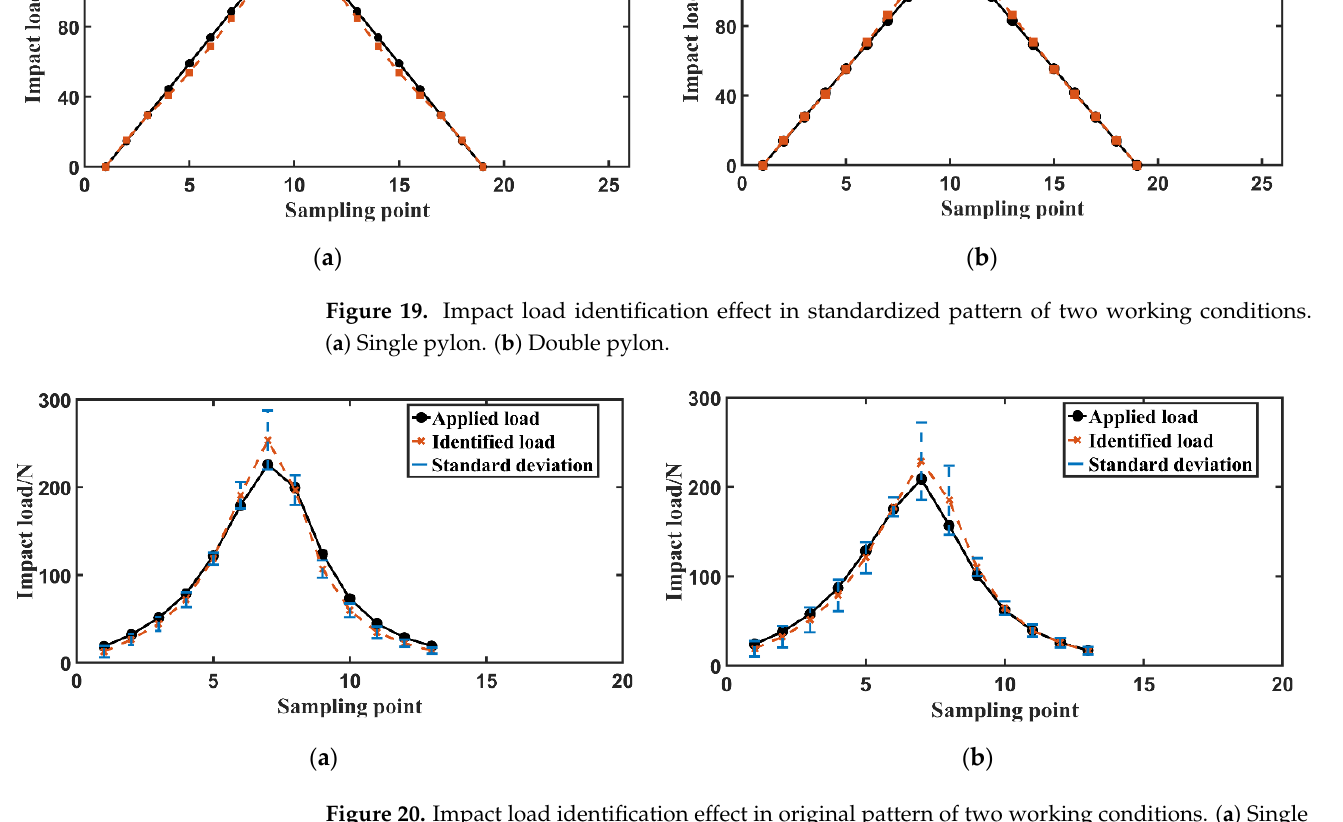
pylon. ( b ) Double pylon.